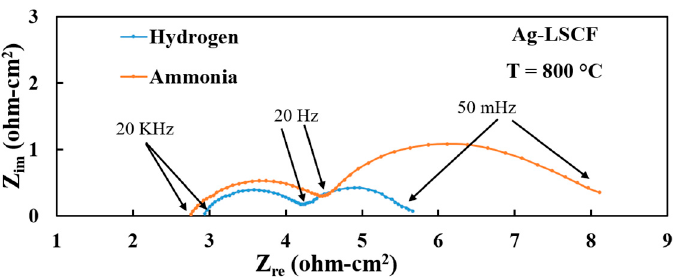
Figure 10. Electrochemical impedance spectra for Ag-LSCF//YSZ//GDC/LSCF ESC with hydrogen (hydrogen = 75 mL/min, air = 75 mL/min) and ammonia fuels (ammonia = 50 mL/min, air = 75 mL/min) at 800 °C.